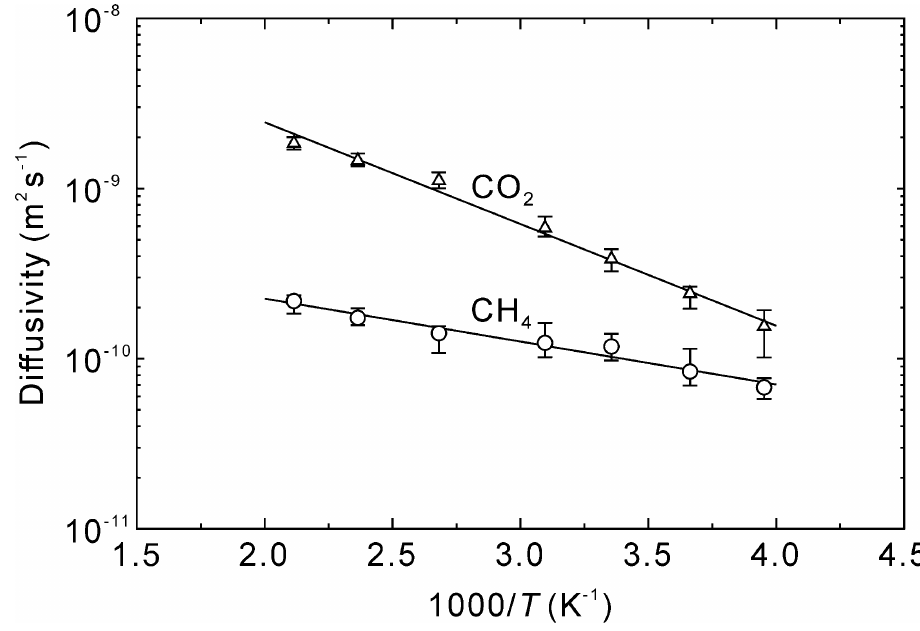
Figure 6. Arrhenius plots of CO 2 and CH 4 diffusivities within the CHA-type zeolite channels. Vujic et al. compared to the simulated CO 2 diffusivities with those obtained by experiments [33], and the simulated diffusivities were twice higher than the experimental values for high silica zeolites. Krishna et al. [42] also simulated the diffusivities of CO 2 and CH 4 in all-silica CHA-type zeolite at 300 K. When the fugacities of CO 2 and CH 4 were 1 MPa, their diffusivities were ca. 4 × 10 − 10 m 2 s − 1 for CO 2 and 8 × 10 − 11 m 2 s − 1 for CH 4 .